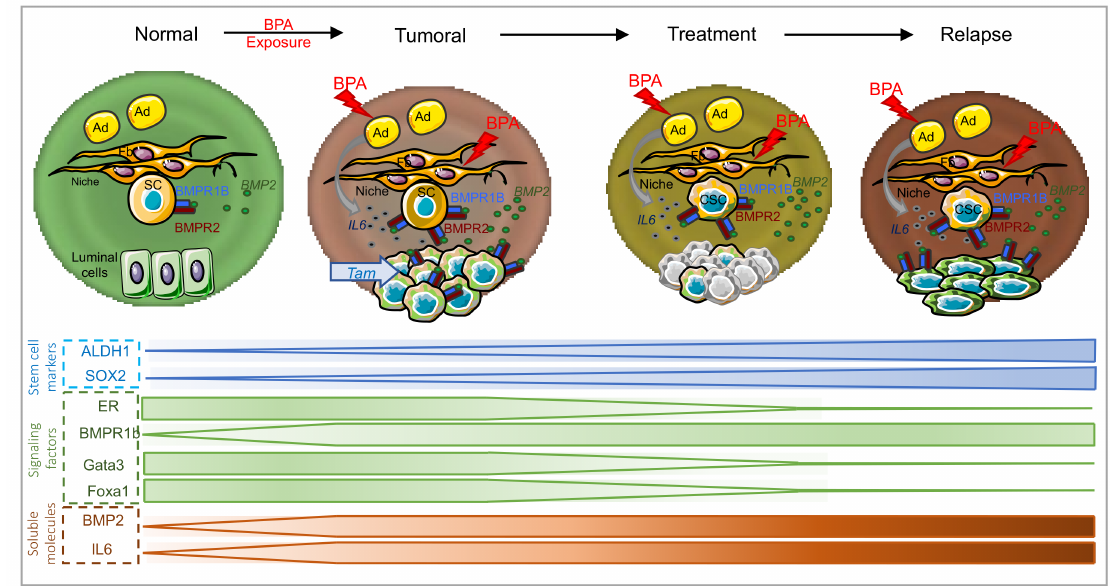
Figure 2. Putative mechanism of BPA involvement during mammary gland carcinogenesis. In the normal breast, the microenvironment secretes factors, BMP2 in particular, that regulate the luminal lineage [43]). Exposure to BPA induces dysregulations in the synthesis of microenvironmental factors: Mammary fibroblasts increase their BMP2 secretion [78] and adipocytes establish an inflammatory environment by releasing IL6 [135]. The microenvironment then becomes permissive to transformation, and in concert with BPA, leads to the initiation and progression of breast tumor. Treatments can kill the tumor bulk, but not cancer stem cells, leading to proliferation and relapse. The relapsing tumor has an aggressive phenotype due to its cancer stem cell origin and / or to pollutants that promote a decrease in epithelial marker expression (Gata3, Foxa1) [127], an increase in mesenchymal markers and stem-like features (ALDH1, SOX2) [136,137] or a loss of ER [128]. Fb, fibroblast; SC, stem cell; Ad, adipocyte; CSC, cancer stem cell; Tam,